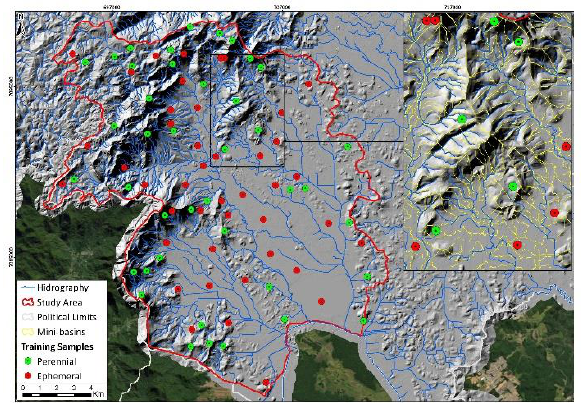
Figure 3: Distribution of sample points in the study area.